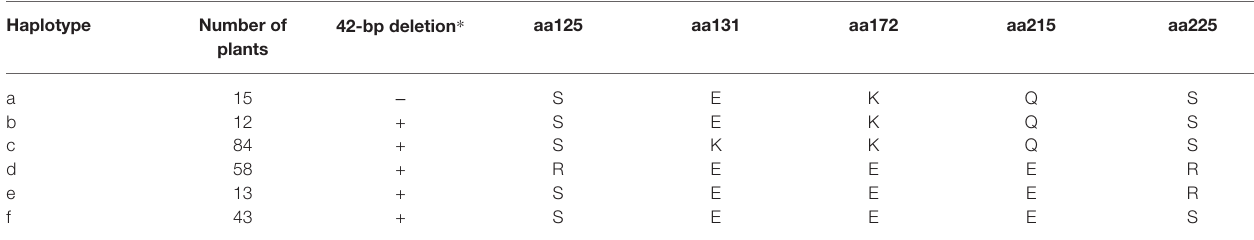
TABLE 6 | Haplotypes based on allelic variation at CaOFP20 in the association panel.